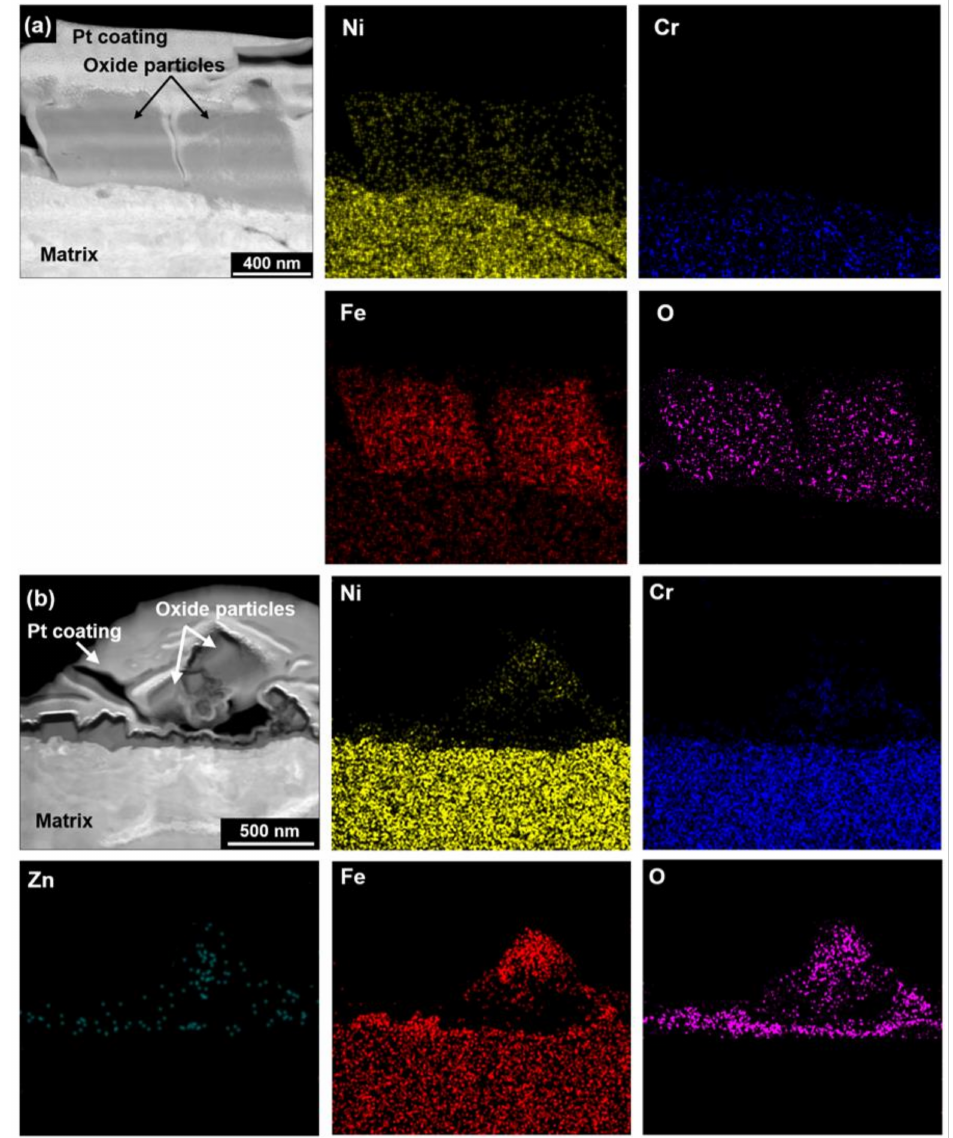
Figure 4. STEM images and EDS elemental maps of oxides grown on Alloy 690 under ( a ) Case #1 and ( b ) #2